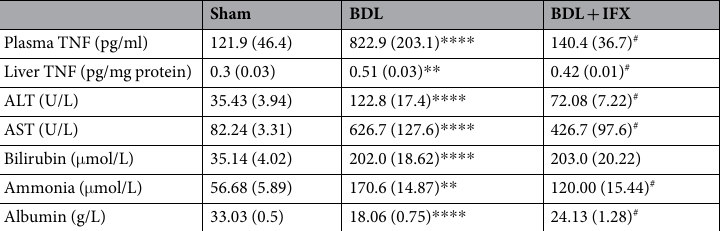
Table 2. Plasma and liver TNF levels and plasma biochemistry measurements. Data are shown as mean (standard error). ** p < 0.01, **** p < 0.0001 compared to Sham. # p < 0.05 compared to BDL. (Sham n = 10; BDL n = 10; BDL + IFX n = 7).